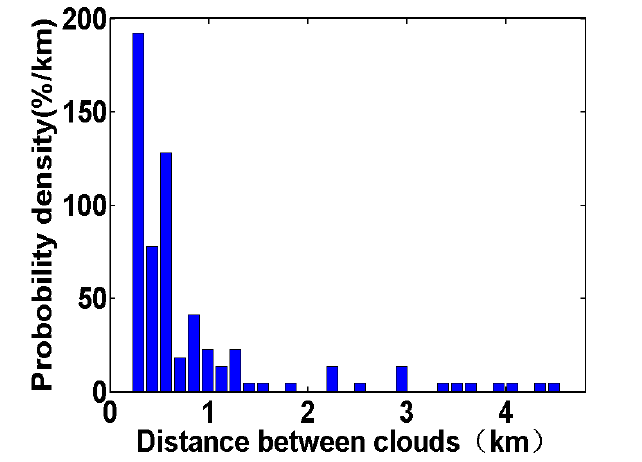
Figure 9. The probability density function of the distance between adjacent